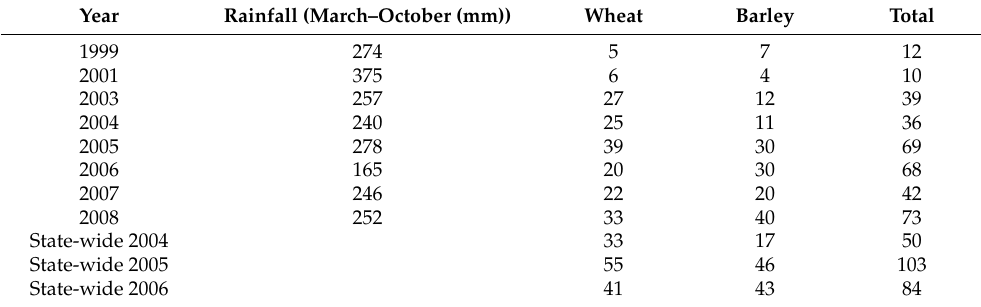
Table A1. Number of fields by year and crop type used in the accuracy assessment of the Yorke Peninsula and State-Wide